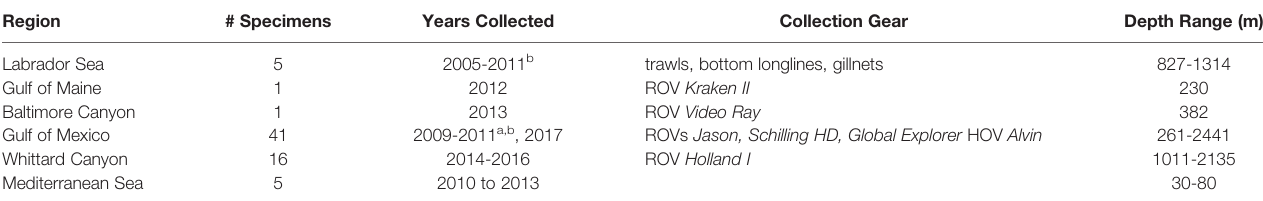
TABLE 1 | Specimen collection